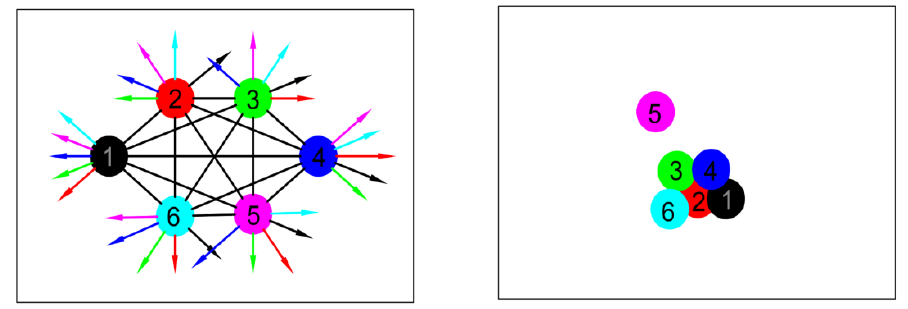
Figure 6. The principle of an all-to-all strategy [25] .